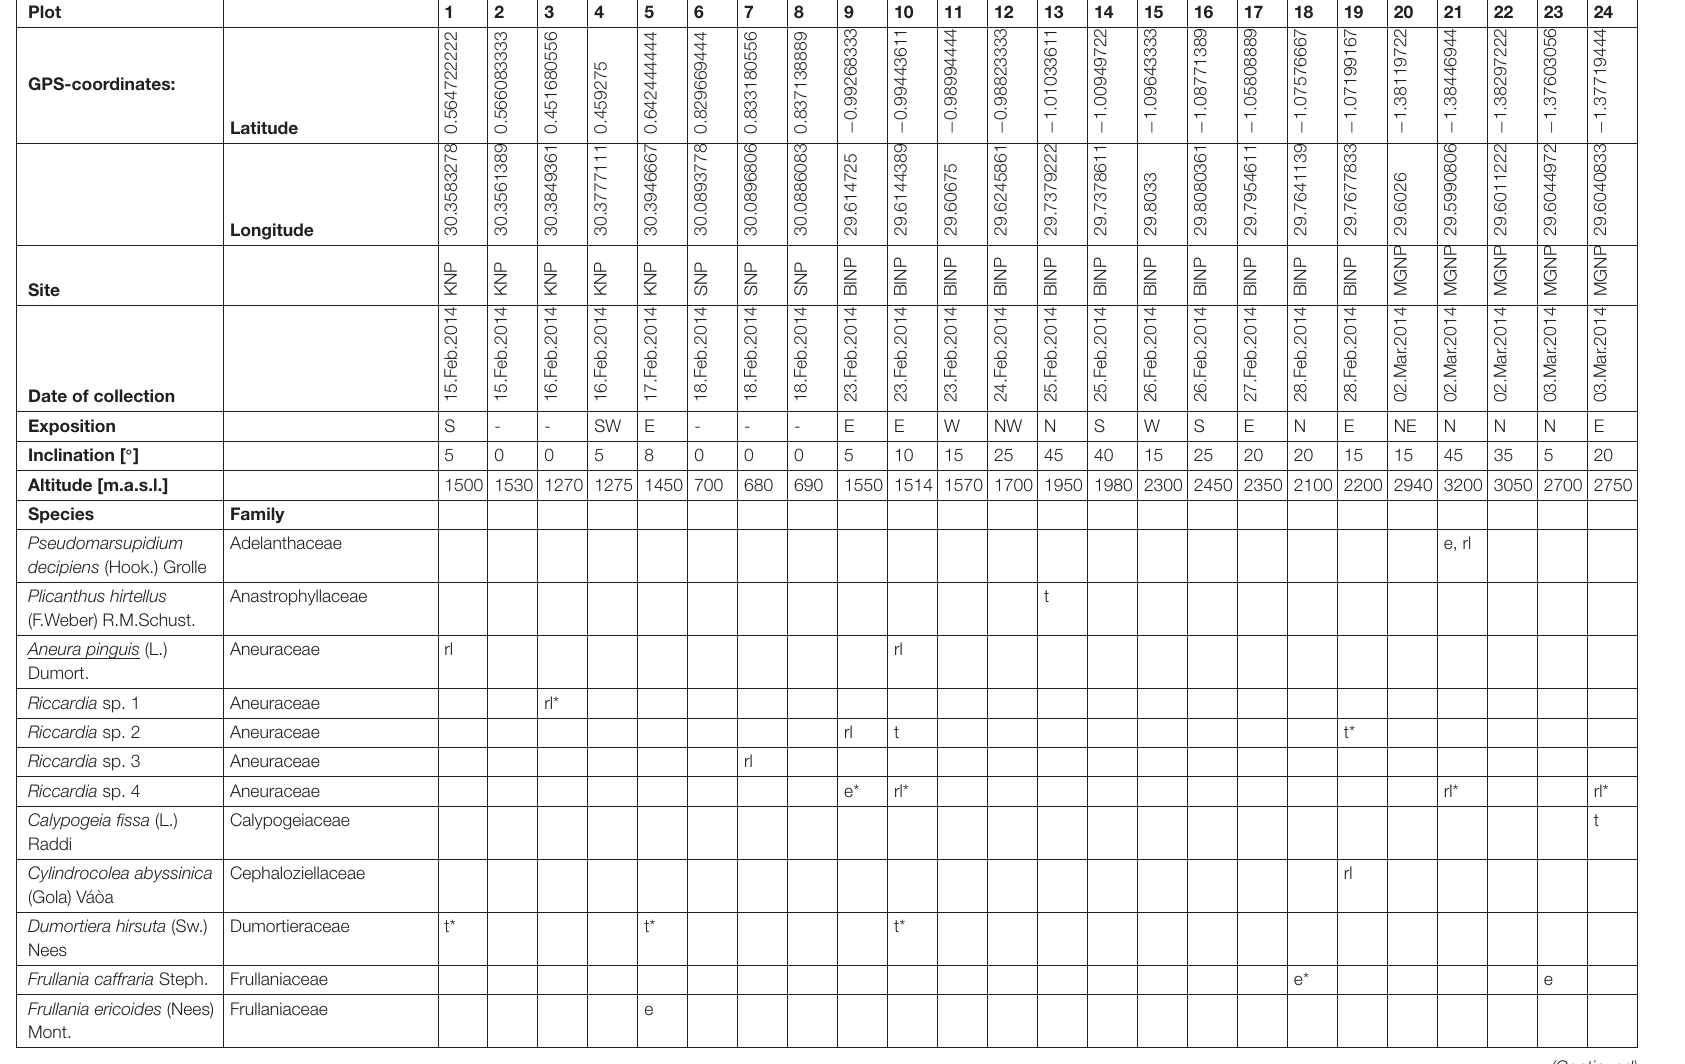
TABLE 2 | Liverwort inventory with collection sites and habitats.